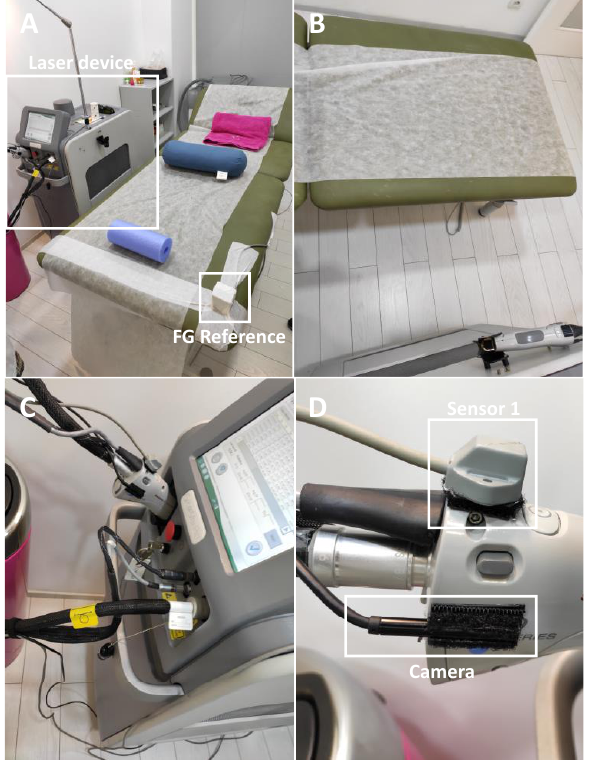
Figure 2. Laser treatment room. The laser device is located to the left of the surgical bed ( A , B ). On the handheld laser device, the electromagnetic sensor and a camera were attached ( C , D ). Note that FG refers to field generator.